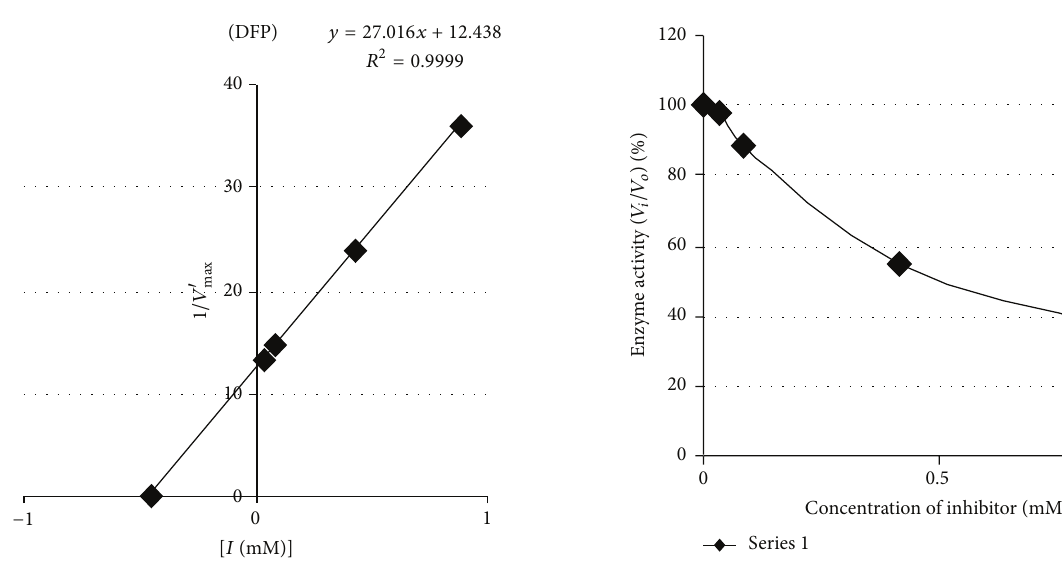
Figure 5: Determination of inhibition constant ( 𝐾 𝑖 ) for DFP.